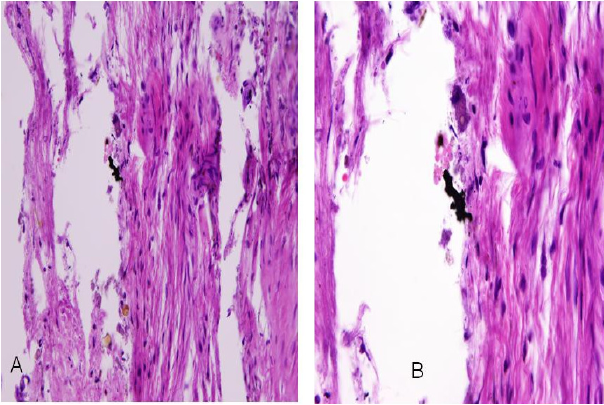
Figure 2. Case 1: Hematoxylin & eosin (H&E) stained section of fibroadipose tissue showing black granular material in aggregates. Original magnifications at 10× and 600×.